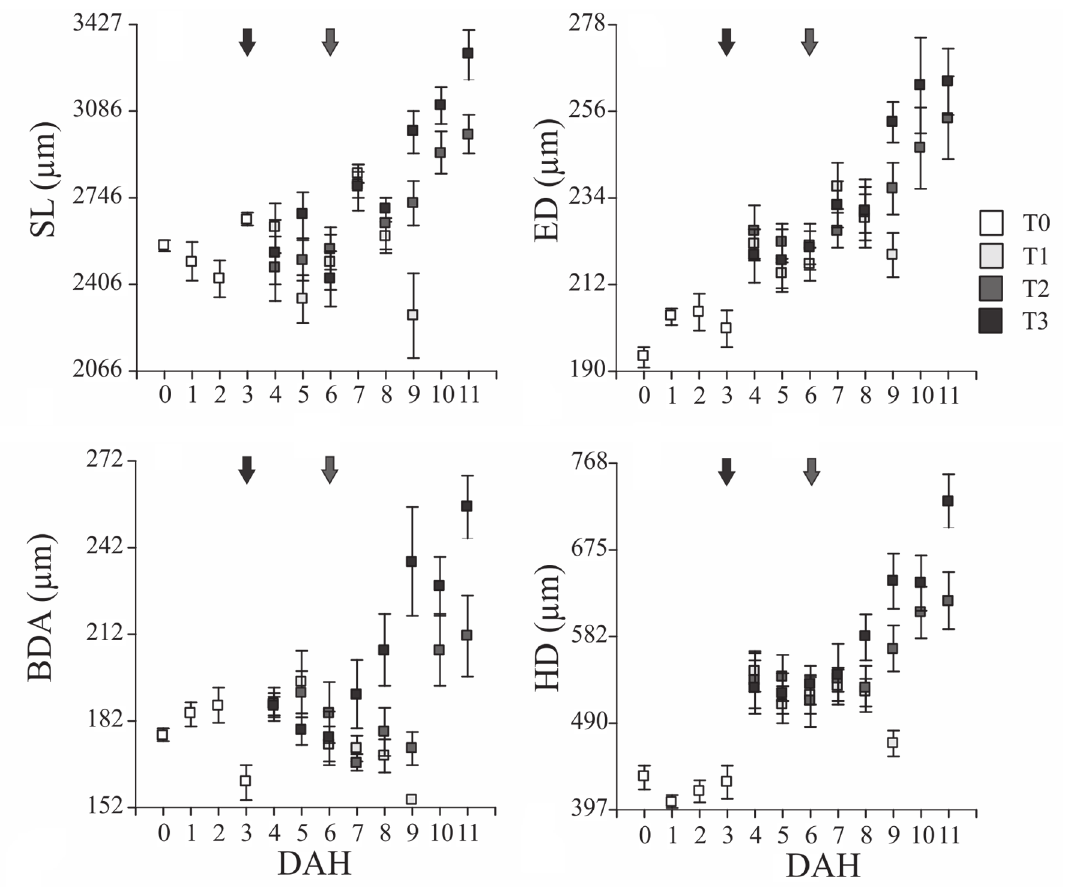
Fig. 1. Mean values of morphometrical variables and standard error against larval age expressed as days after hatching (DAH) of Pagrus pagrus larvae from the different feeding treatments. BDA: body depth at the anus, ED: eye diameter, HD: head depth, SL: standard length. T0: before the experiment begins, T1: without food, T2: delayed feeding and T3: fed. Arrows indicate the moment when food was supplied to larvae in T3 (black) and T2 (dark grey). Initial condition of larvae (T0, white squares) was also included in order to allow